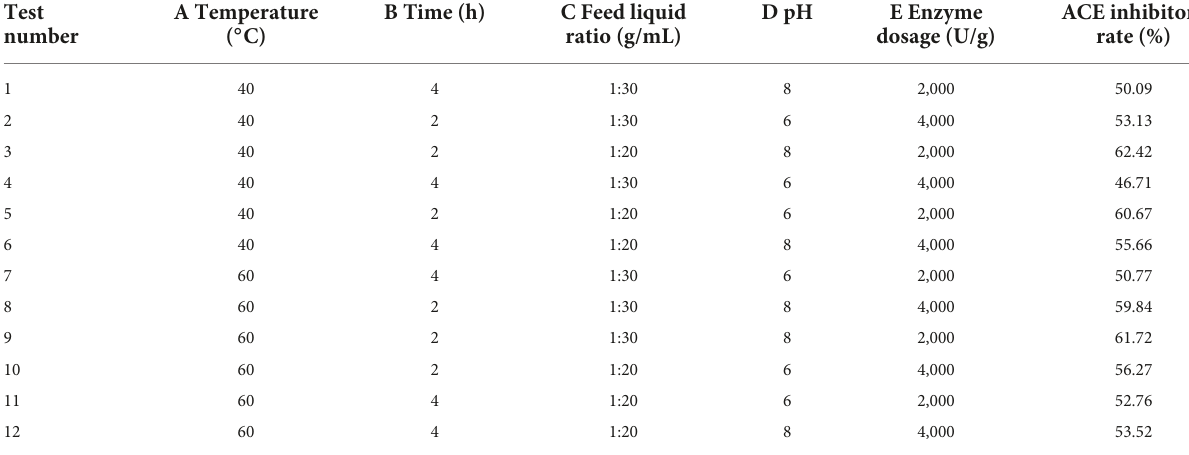
TABLE 1 Plackett–Burman design and corresponding results.